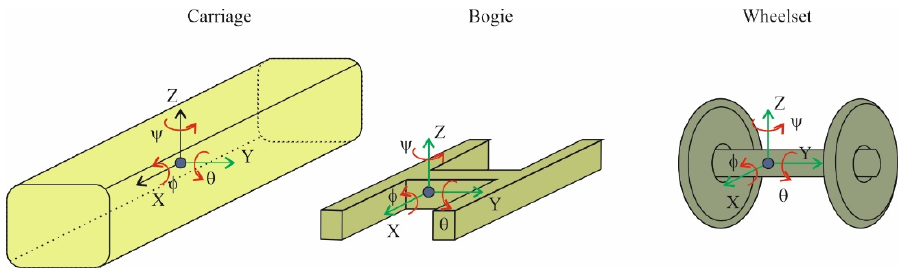
Figure 3. Elements of a rail vehicle with coordinate systems.